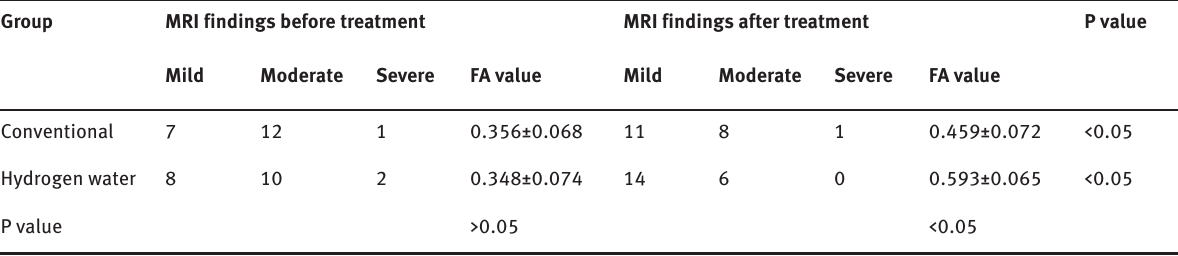
Table 3: A comparison of the MRI findings between the conventional treatment group and the hydrogen water treatment group (x±s). Group